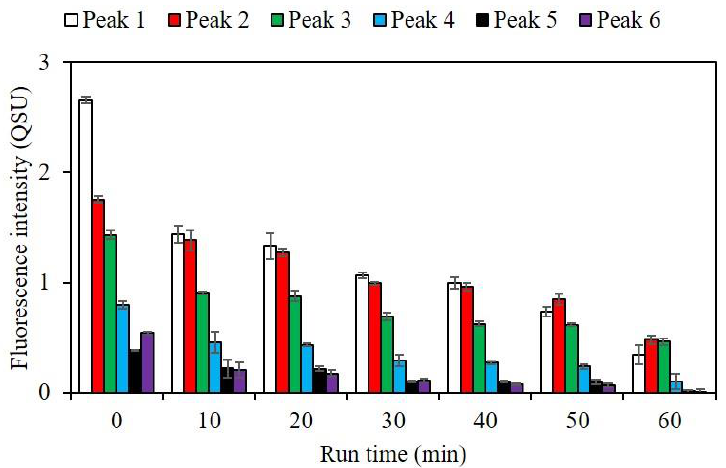
Figure 5. The changes of fluorescence DOM composition during RF treatment ( n = 8). Peak 1: protein-like tyrosine; Peaks 2 and 4: protein-like tryptophan; Peak 3: fulvic acid-like; Peak 5: marine humic-like; Peak 6: humic-like.